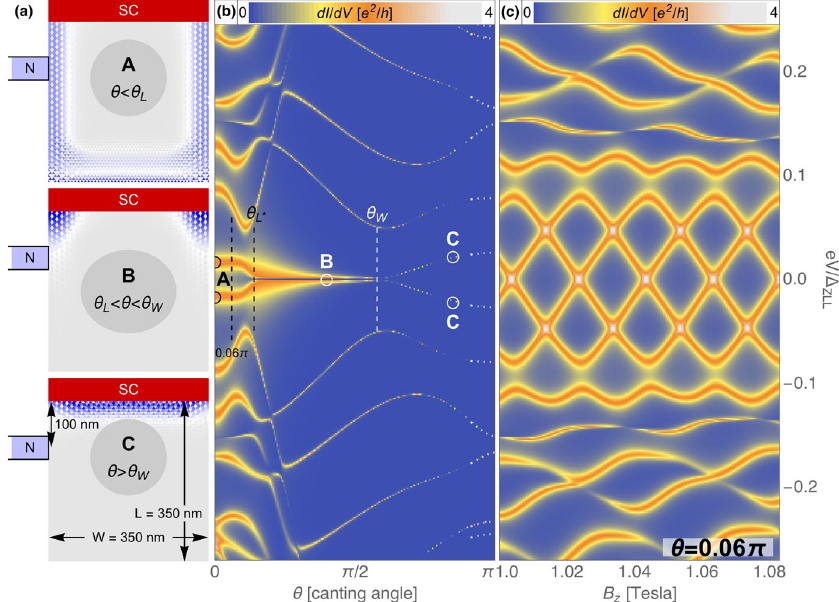
FIG. 4. (a) 350 nm × 350 nm sample with a single superconducting contact, otherwise identical to system of Fig. 3, main text. (b) and (c) show the differential conductance as a function of canting angle θ and out of plane magnetic field B phenomenology as panels (b) and (e) of the two contact setup in Fig. 3, albeit with a simpler two-Majorana geometry, and with the total length of the vacuum edge L (cid:3) ¼ 2 L þ W playing the role of L